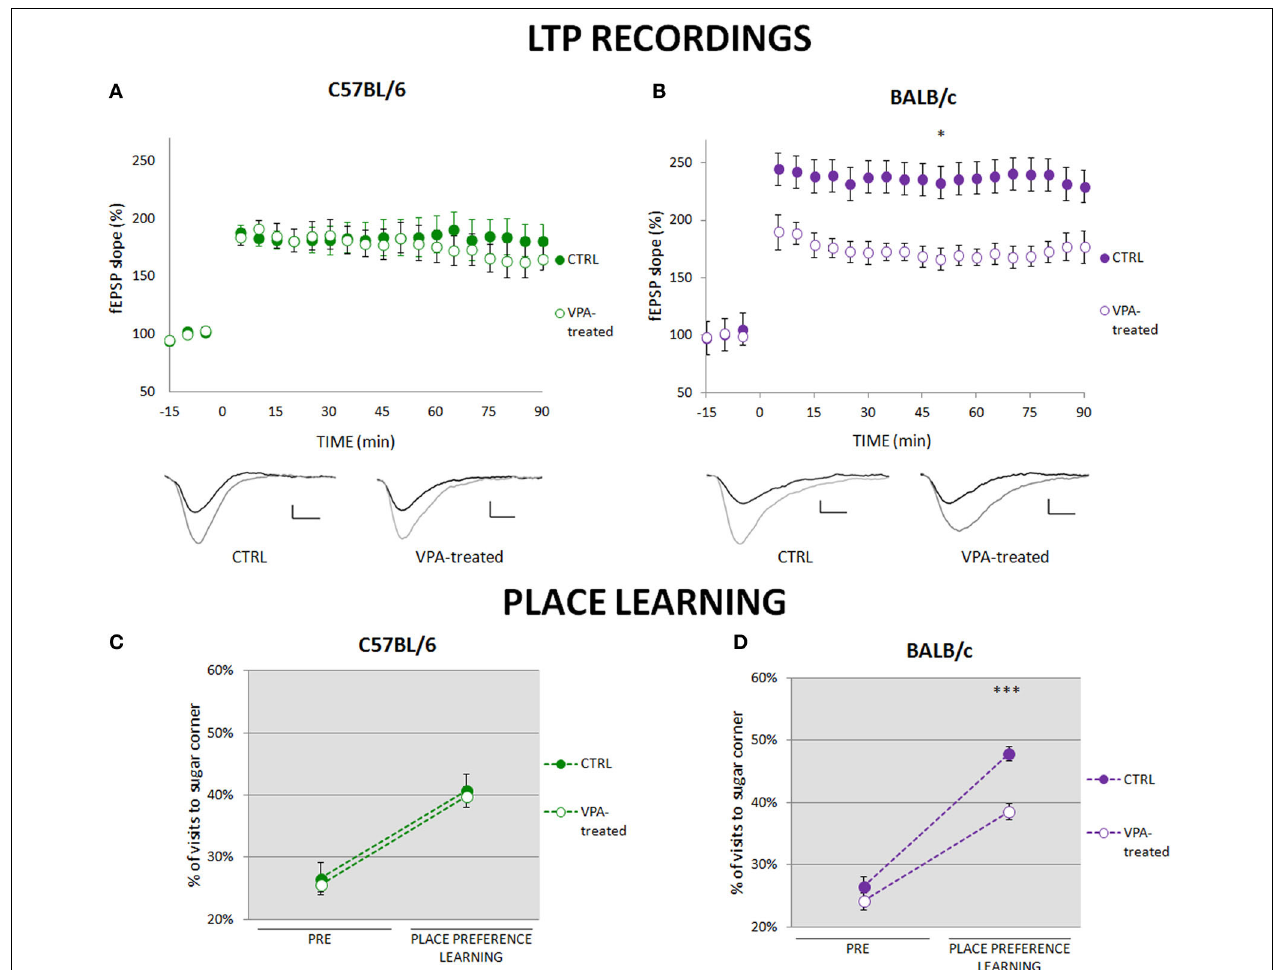
and control ( n = 41) C57BL/6 mice acquired place preference at the same level. (D) Valproate-treated BALB/c mice ( n = 42) showed impaired place preference learning comparing to the control animals ( n = 29; Mann-Whitney U -Test comparisons of two independent groups). Dots represent the actual data, while dashed lines serve to guide the eye. Error bars represent s.e.m. ∗ p < 0 . 05, ∗∗∗ p < 0 . 001.